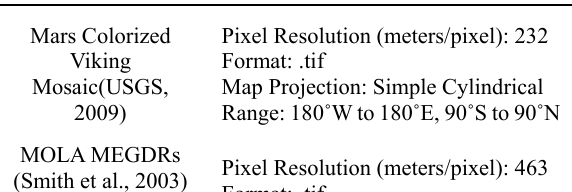
Figure 6. Design and simulation of the Mars exploration mission using Sino-Mars (Table 1) and space environment model (IGRF-12